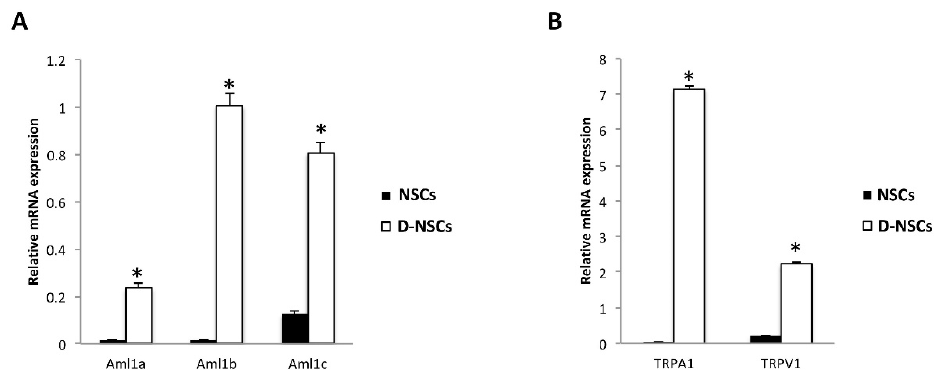
Figure 1. Phenotype characterization of NSCs: ( A ) The relative Aml1 isoforms mRNA expression in NSCs (NSC#1 and NSC#2) and D-NSCs (D-NSC#1 and D-NSC#2) evaluated by qRT-PCR. ( B ) The relative TRPA1 and TRPV1 mRNA expression in NSCs (NSC#1 and NSC#2) and D-NSCs (D-NSC#1 and D-NSC#2) evaluated by qRT-PCR. AML1 , TRPA1 and TRPV1 mRNA levels were normalized for GAPDH expression. Data are expressed as mean ± SD. * p < 0.001 vs. NSCs.